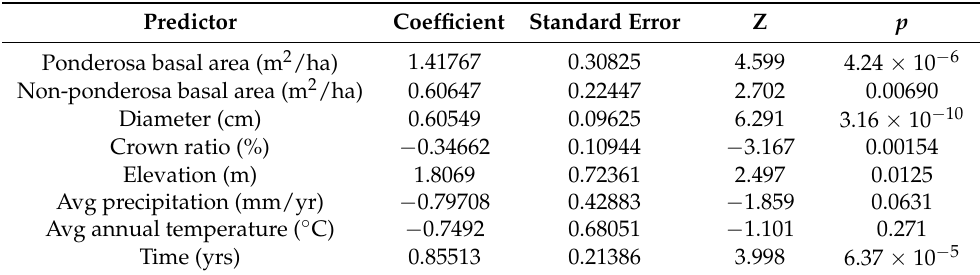
Table A4. Outputs from the Objective 2 model in which climate variables were included with all significant stand- and tree-level variables. Predictors have been mean-centered and scaled by their standard deviation.